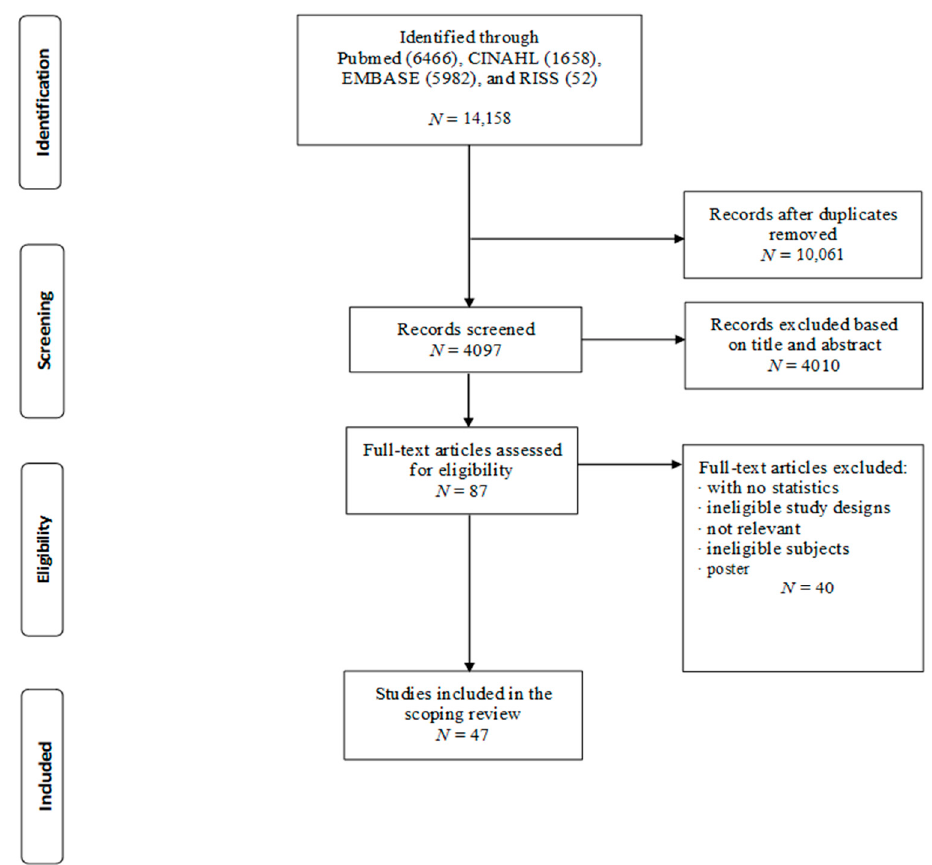
Figure 1. PRISMA flowchart of article selection. Table 1. Analysis framework of determinants of